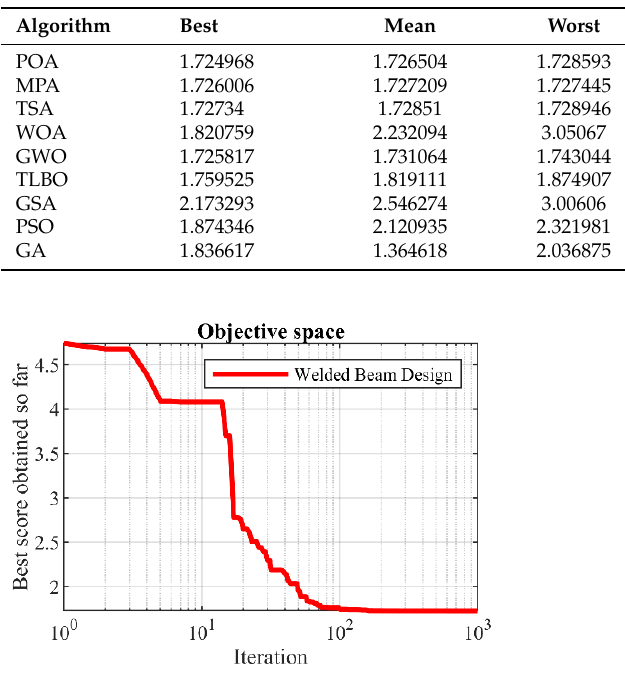
Figure 10. POA’s performance convergence curve on welded beam design.